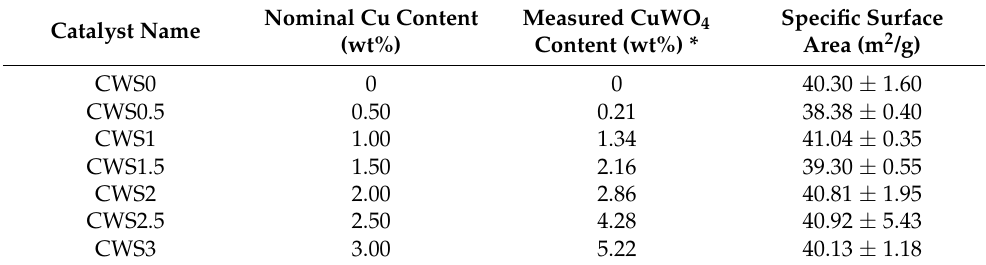
Table 1. Nominal and measured CuWO 4 concentrations and specific surface area of the